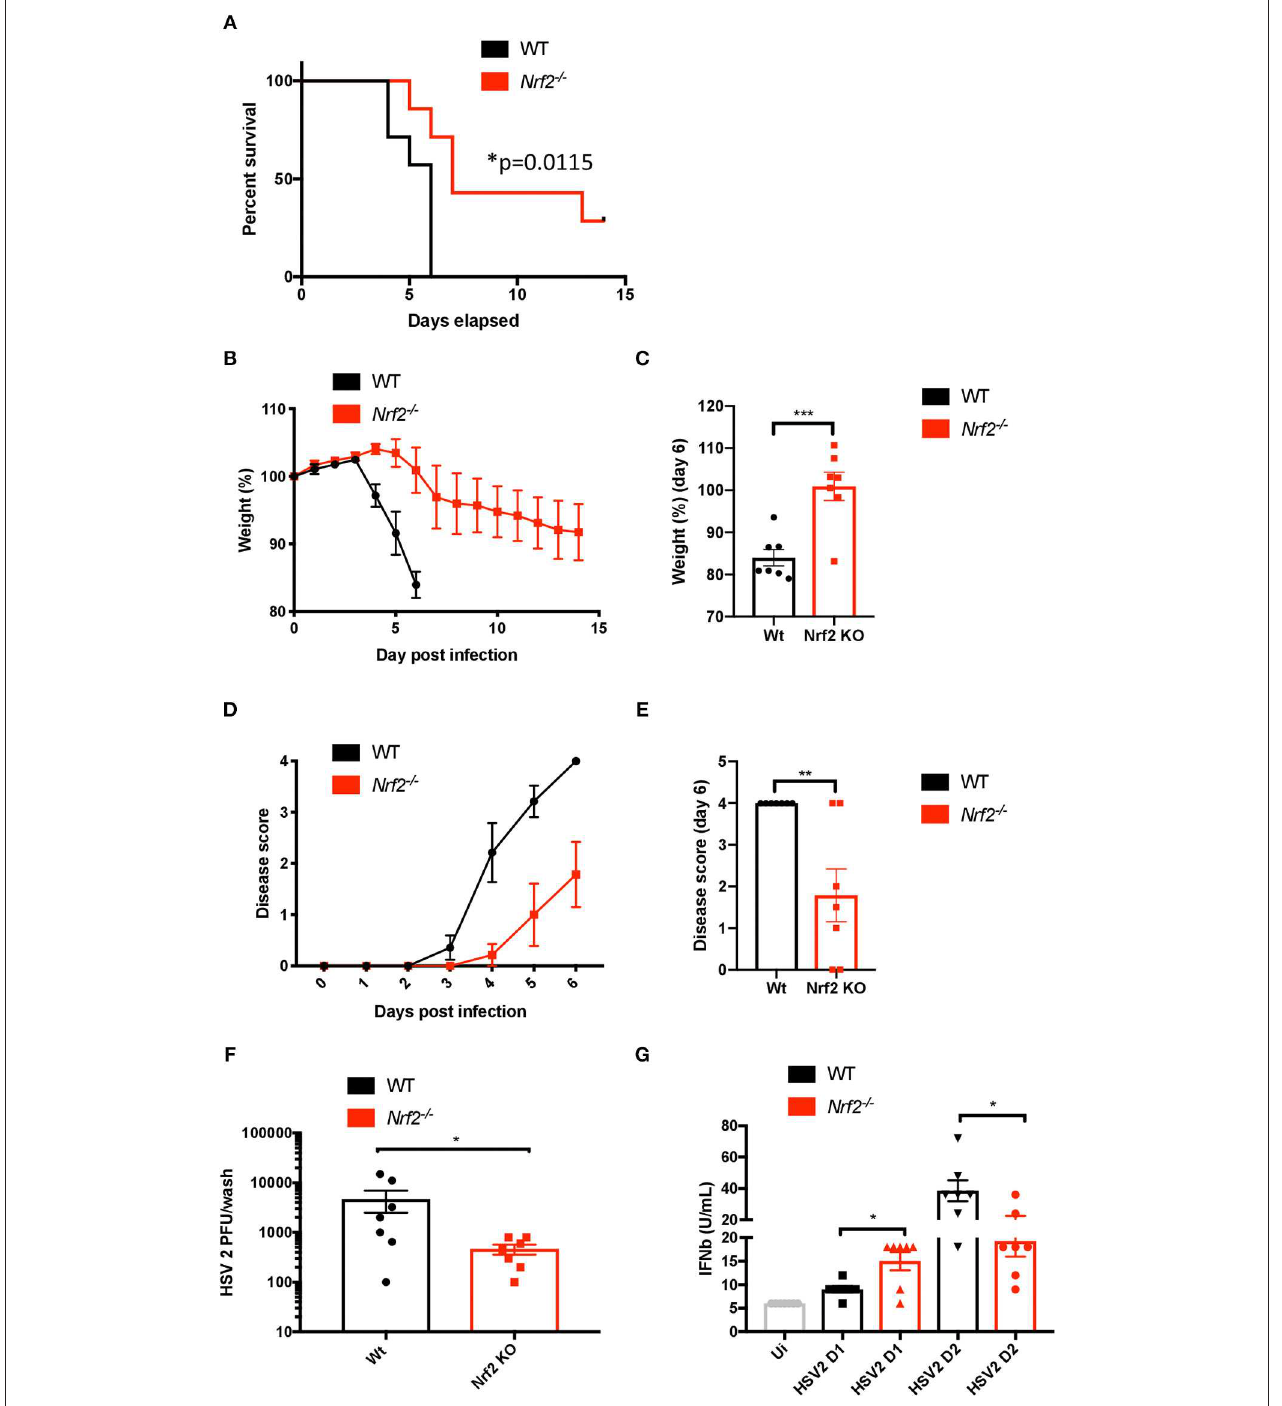
FIGURE 5 | Lack of Nrf2 protects mice from HSV-2 vaginal infection and delays physiopathology. WT and Nrf2 KO mice were infected intravaginally with HSV-2, strain 333 (3.33 × 10 5 PFU/mouse). (A) Survival, (B,C) weight loss and (D,E) disease evolution score were measured over time ( n = 7 mice). (F) After 1 day of infection, vaginal washes were collected for use in plaque assay to estimate HSV-2 titers ( n = 7). (G) Type I IFN bioactivity in the vaginal washes was assessed by in vitro bioassay ( n = 7).